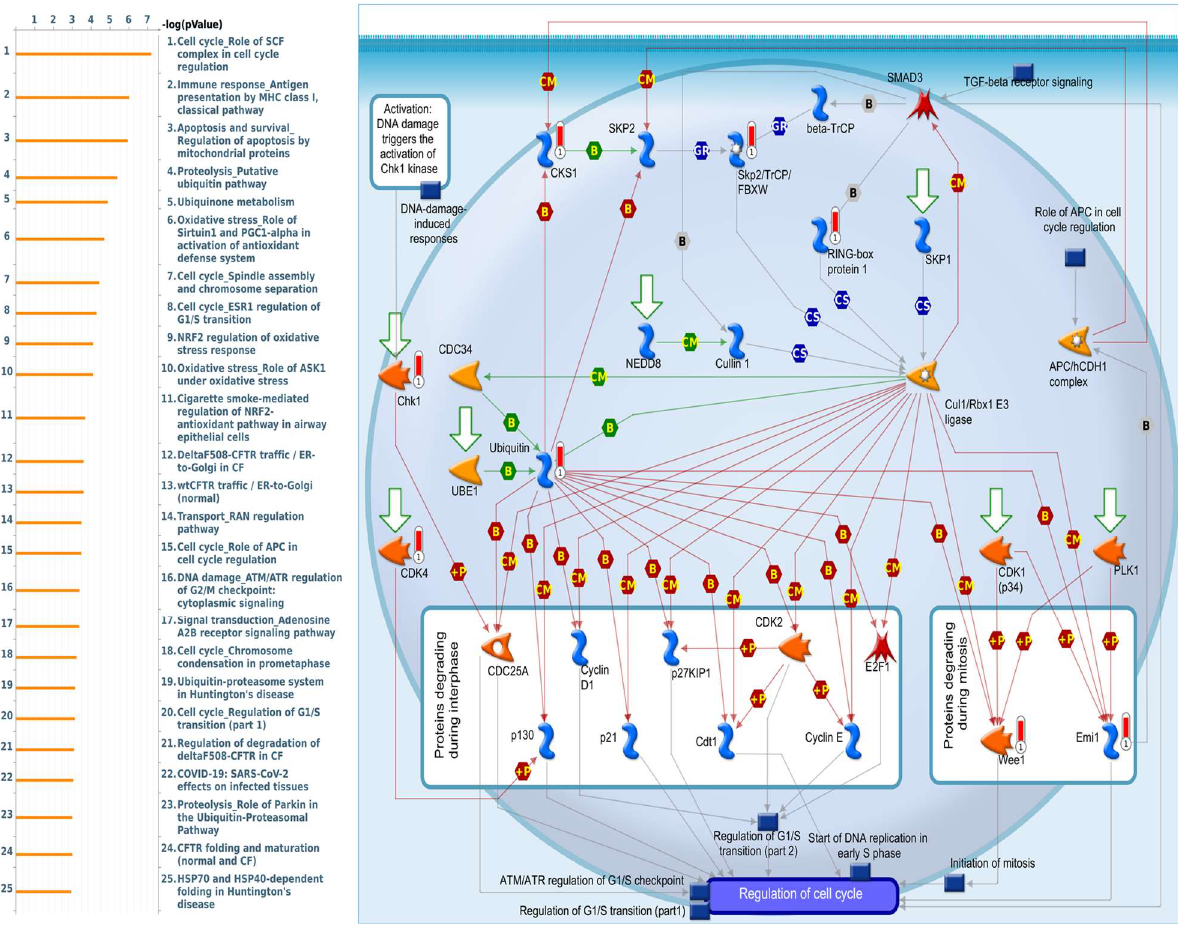
Figure 5. MetaCore pathway analysis of the coexpression gene network of proteasome 20S subunit alpha 1 (PSMA1) in breast cancer patients. We used the MetaCore platform to analyze genes coexpressed with PSMA1 from the associated METABRIC and TCGA datasets, and downstream pathway analyses revealed that “Cell cycle_Role of SCF complex in cell cycle regulation” participates in breast cancer development.